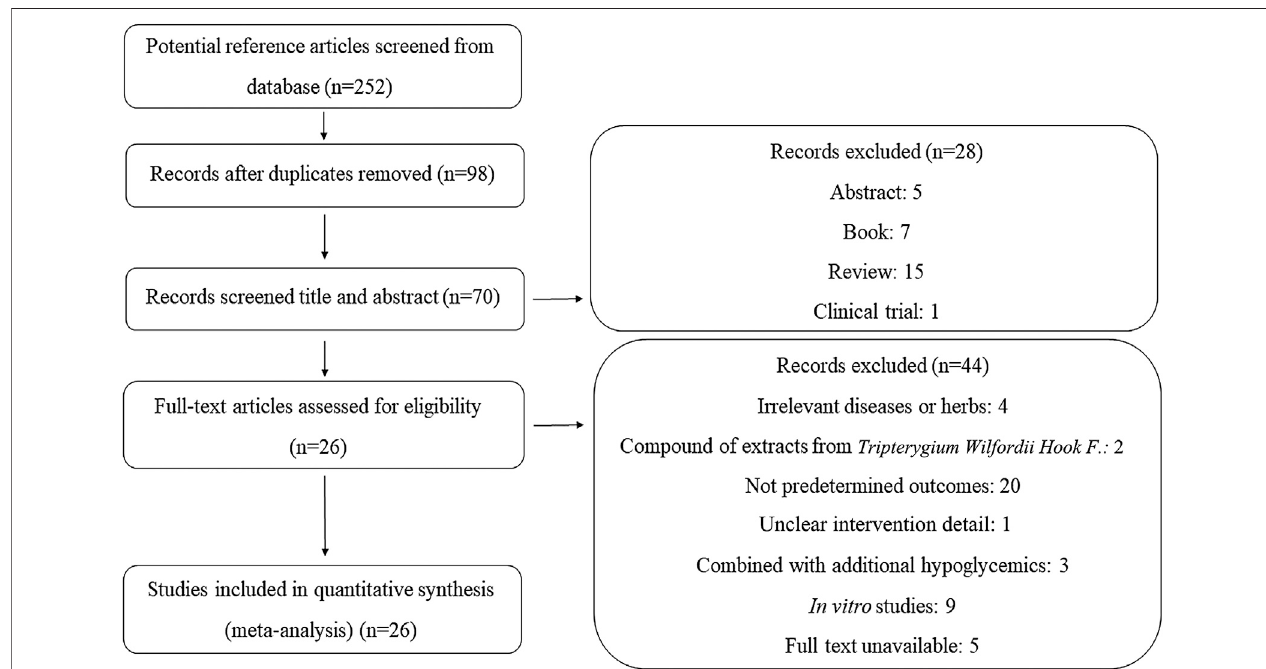
FIGURE 1 | Flow chart of the screening